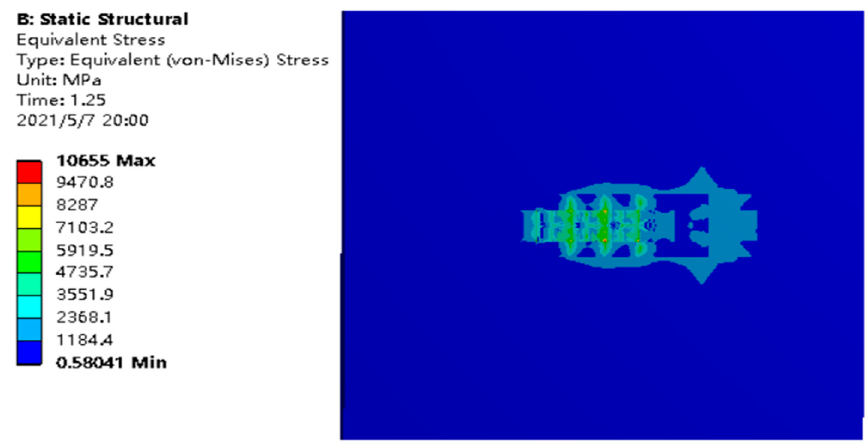
Figure 10. Stress under thermal stress.